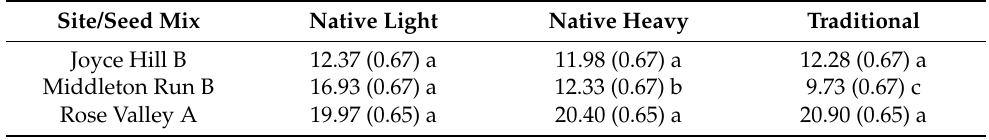
Table 4. Cation exchange capacity (CEC; cmol c kg − 1 ) by site and seed mix treatment. Values are estimated marginal means with one standard error in parentheses. Šid á k-adjusted comparisons were made among estimated marginal means. Growing seasons followed by the same upper-case letter are not significantly different at p < 0.05. Pairs of values of the seed mix treatment within a site followed by the same lower-case letter are not significantly different at p < 0.05.